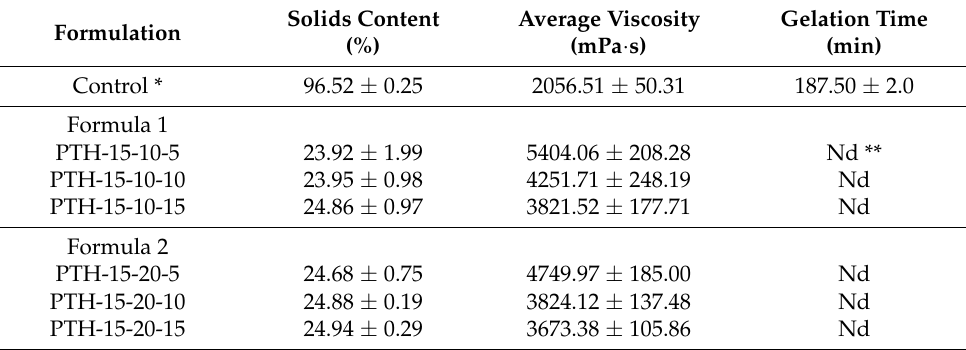
Table 3. Basic properties of PVOH–lignin–hexamine (PTH)-based adhesive. Formulation